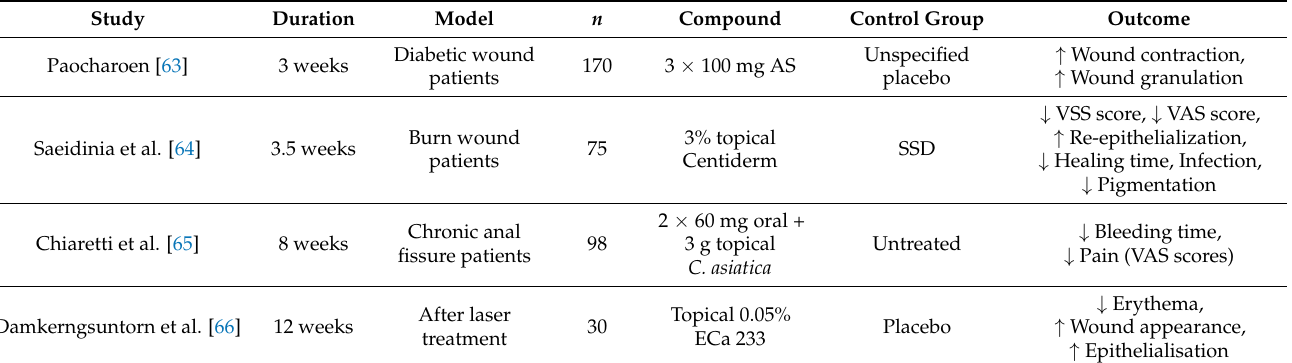
Table 2. Studies evaluating the effect of Centella asiatica treatment on wound healing and reported